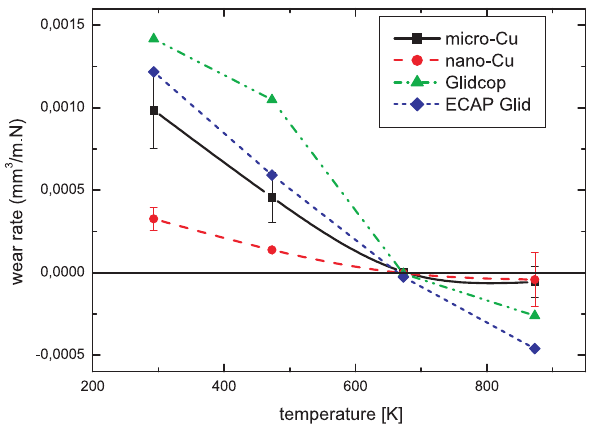
Fig. 4: Temperature variance of wear rates.